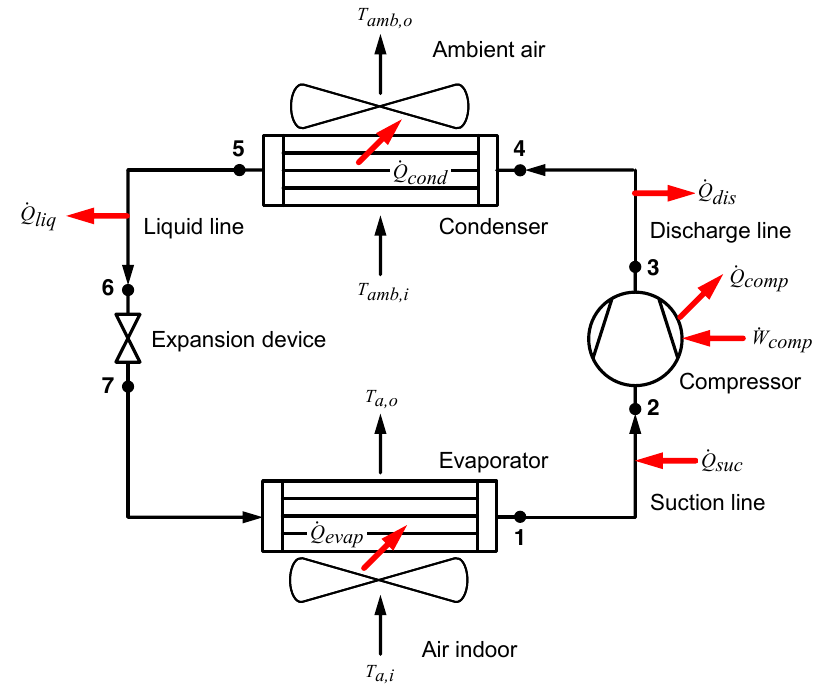
Figure 1. Schematic diagram of the vapor compression